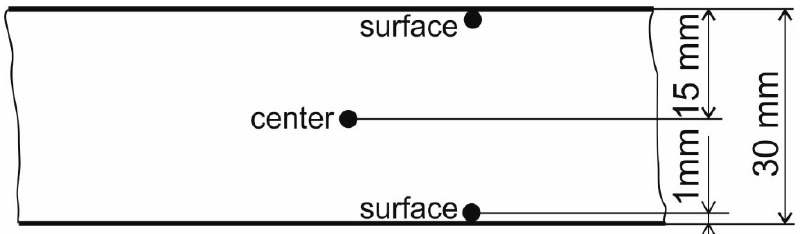
Figure 1. Location of thermocouples in samples.